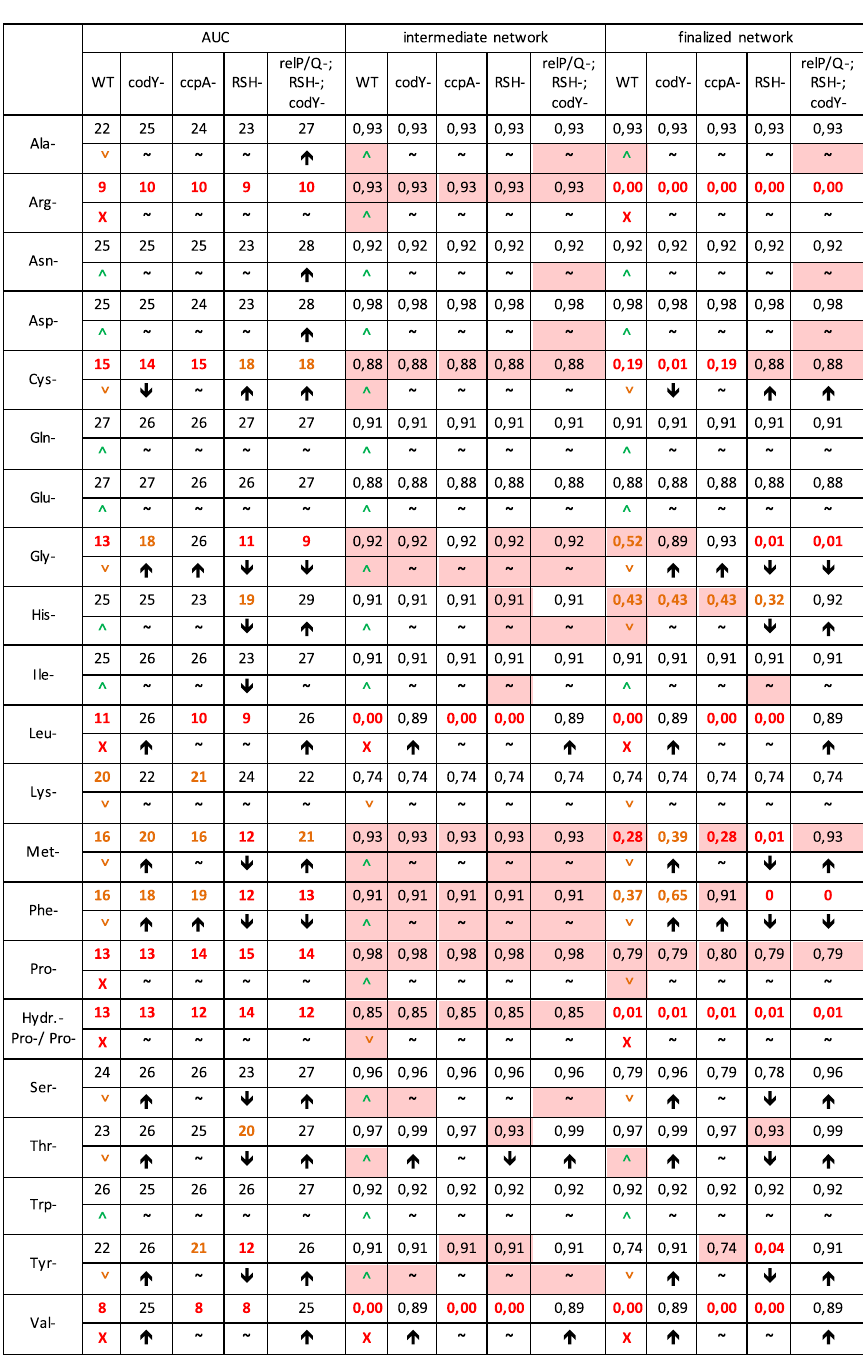
Table 3. Semi quantitative and qualitative in vitro–in silico comparison. The values were categorized for semi- quantitative evaluation via the AUC of the growth curves (essential AA: AUC 8–15 in red; average synthesis performance: AUC 16–21 orange; high synthesis performance: AUC 22–29 in black). The essential amino acids of the WT determined in this way are Arg, Cys, Gly, Leu, Pro, Val. Based on the AUC of the KO strains in the respective deficient media, the influence of the corresponding knocked-out node on the synthesis performance of the withdrawn AS can be evaluated. For the semi-quantitative evaluation of the in silico experiments the values were categorized too (essential AS 0.00–0.29 in red, average synthesis performance 0.30–0.69 in orange; high synthesis performance 0.7–1.0 in black). The semi-quantitatively mismatching results are highlighted in red. Moreover the qualitative evaluation of the growth curves of the WT is shown. With ˄ , ˅ and X an uninhibited, an inhibited and no synthesis is indicated (each in comparison to the WT in full medium). For the KO strains, arrows indicate whether without this node the synthesis performance is impaired or improved or switched off compared to the WT. The in silico results (initial network and definitive network) were also assessed qualitatively in accordance with the qualitative assessment of the growth curves of the WT and the KO strains. The qualitatively inconsistent results are highlighted in